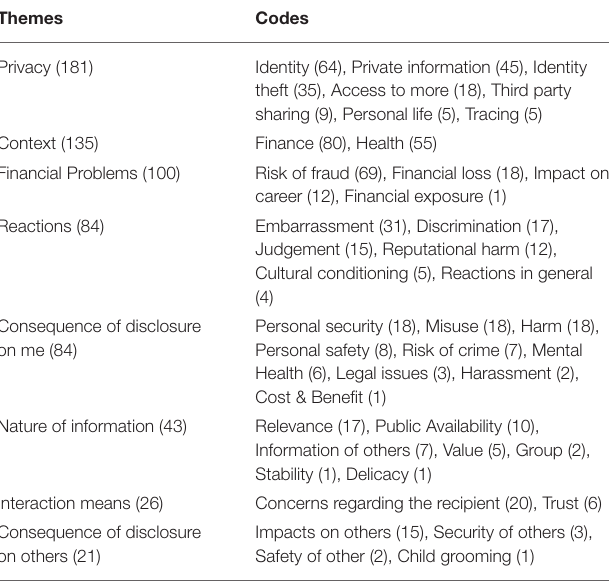
TABLE 5 | Thematic analysis of what makes data